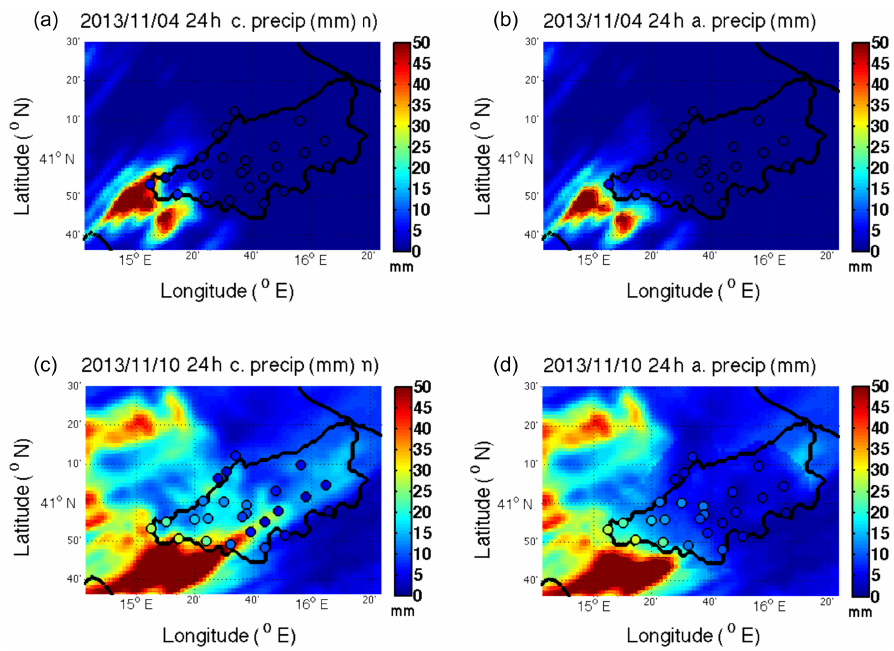
Figure 11. Maps of 24h cumulated precipitations (in mmday − 1 , colours) on 4 November 2011 (top panels) and 10 November 2013 (bottom panels): shaded maps of modelled (left panel) and assimilated (right panel) precipitation with overlapping observed spots on the Ofanto basin. Table 6. Statistical indices for validation of river streamflow by comparison with Cafiero gauge station. Statistical